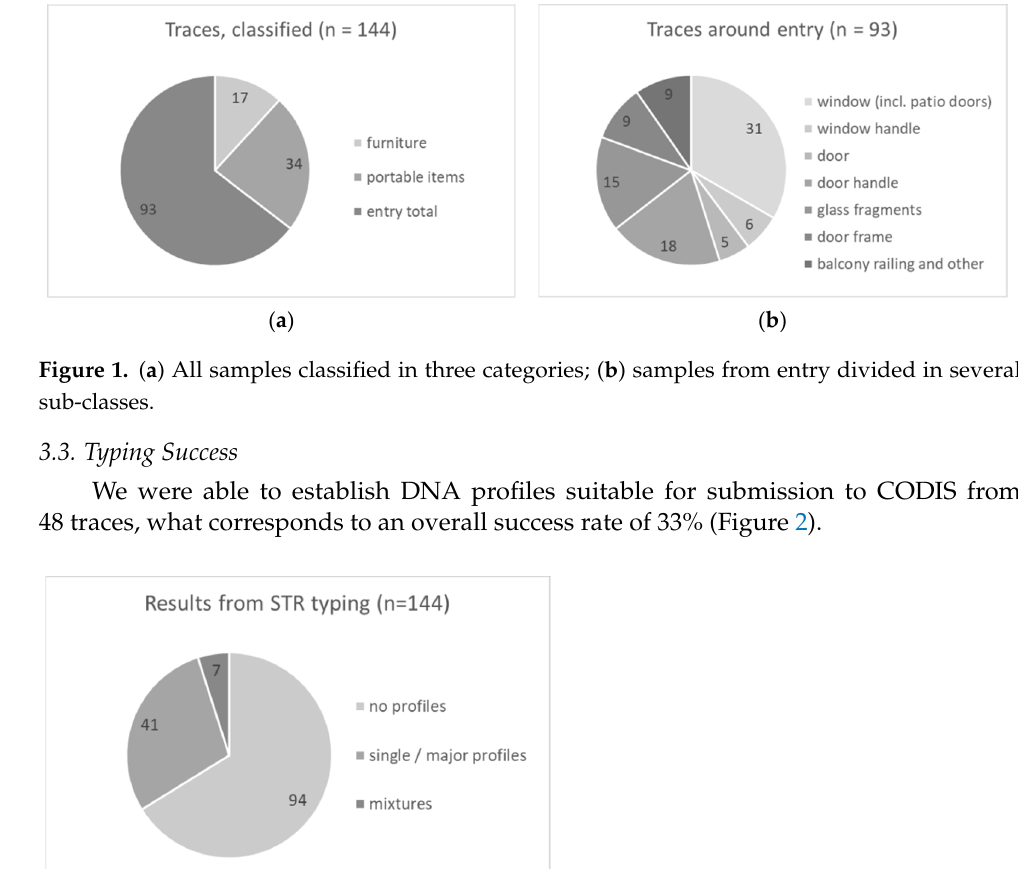
( b ) Figure 3. Histograms of the distributions of DNA amounts in ng obtained from: ( a ) all samples and ( b ) samples for which we were able to establish CODIS-suitable DNA profiles. Figure 4. Fraction of samples of the respective class that resulted in CODIS-suitable DNA profiles. 3.4. Comparison with Reference Samples The 48 CODIS-suitable profiles include interpretable components from 57 DNA con- tributors. We obtained 41 single or major component profiles and 7 two-person mixtures.